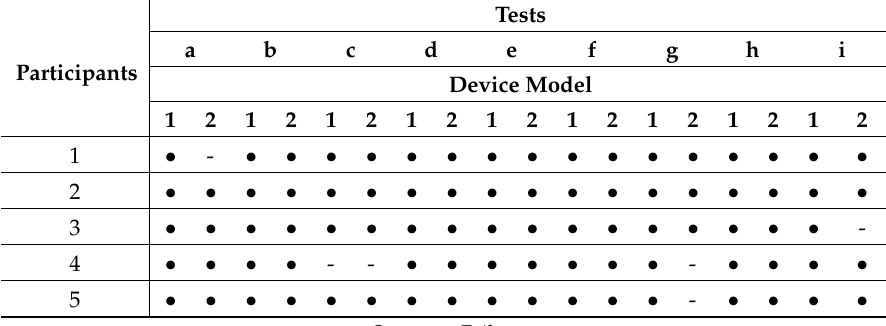
Table 2. Results of the experiments.